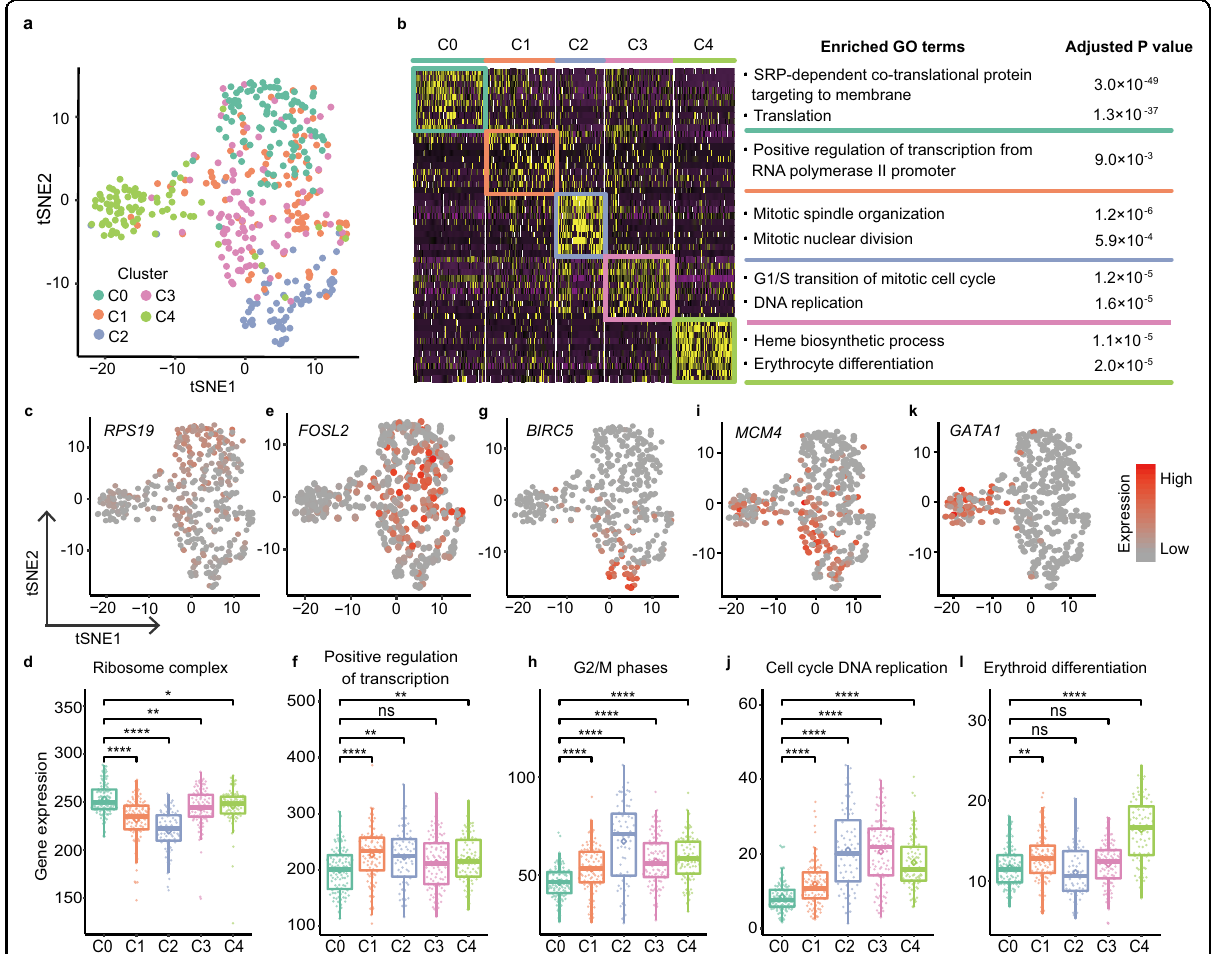
Fig. 2 Erythroid progenitors in normal individuals are heterogeneous. a t-SNE visualization of distinct cell clusters of normal control (NC) BFU-E cells. b Heatmap (left) showing top ten marker genes and the enriched top GO terms (right) of each cluster. c , e , g , i , k The indicated marker genes of each cluster are color-coded and shown on t-SNE plots. d , f , h , j and l Beeswarm plots depict the expression of the indicated gene sets across clusters. Each dot represents the expression value of a single cell that was calculated by summing the log 2 transformed UMI of every gene within the gene set. The diamond represents the mean expression value for each cluster, and the box represents the median and quartiles. P values were determined using Wilcoxon rank sum tests. **** P ≤ 0.0001, ** P ≤ 0.01 and * P ≤ 0.05, ns, no signi fi cance. See also Supplementary Fig. S2 and Tables S3 –